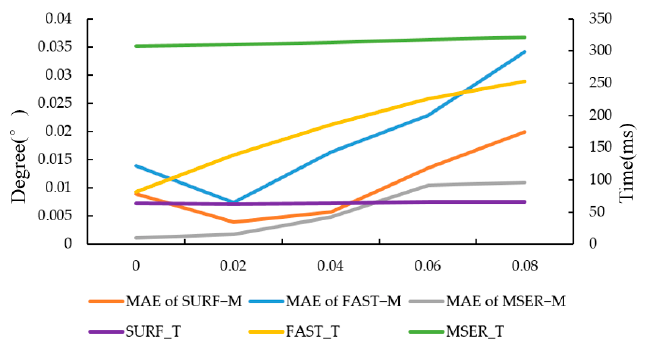
Figure 7. The result of FAST − M, SURF − M and MSER − M. MAE means mean absolute error, while FAST_T, MSER_T and SURF_T mean the running times of the algorithms, respectively.